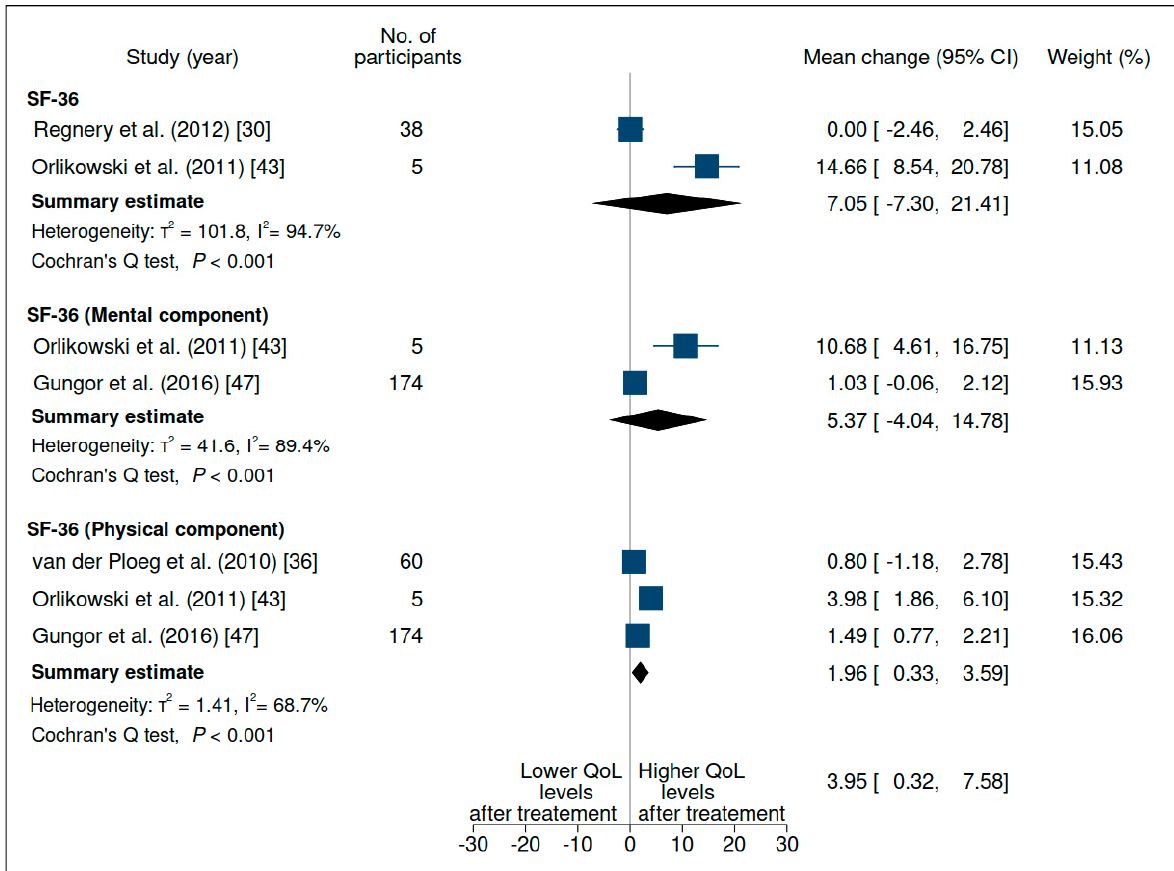
Figure 6. Evaluation of the quality of life of patients with late-onset Pompe disease on enzyme replacement therapy with alglucosidase alfa. Weights are inverse-variance weights and are proportional to the contribution of each study to the summary estimate. I² is the fraction of variance that is due to statistical heterogeneity and not chance. Tau² denotes the between-study variance.